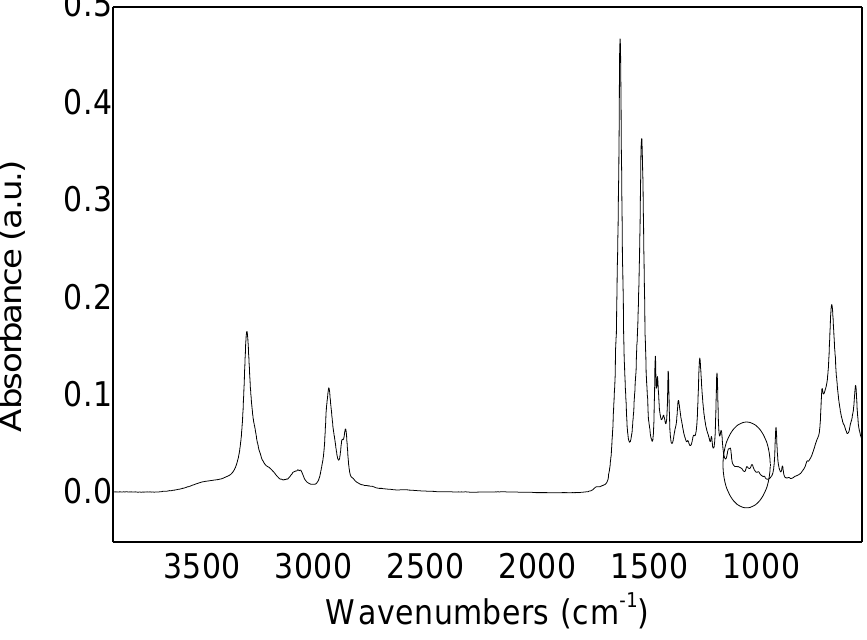
Figure 11. FT–IR of the nylon filter membrane.